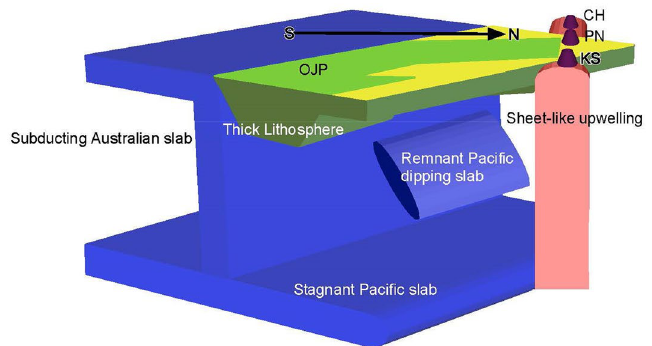
Figure 5. Illustration representing the characteristics observed in in this study: fast anomalies corresponding to the thick lithosphere of the OJP, remnant Pacific dipping slab and stagnant Pacific slab, and sheet-like slow anomalies corresponding to the upwelling along the Caroline volcanic island